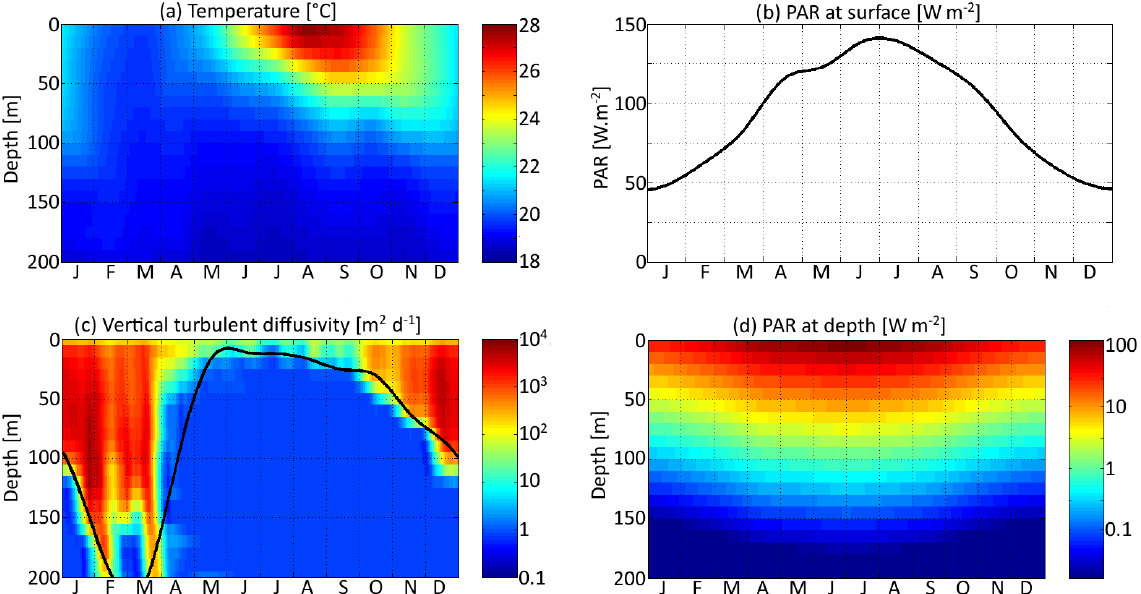
Figure 3. Distribution in depth and time of three environmental variables: (a) temperature, (b, d) photosynthetically active radiation (PAR), and (c) vertical turbulent diffusivity. The black curve in (d) represents the lower limit of the mixed